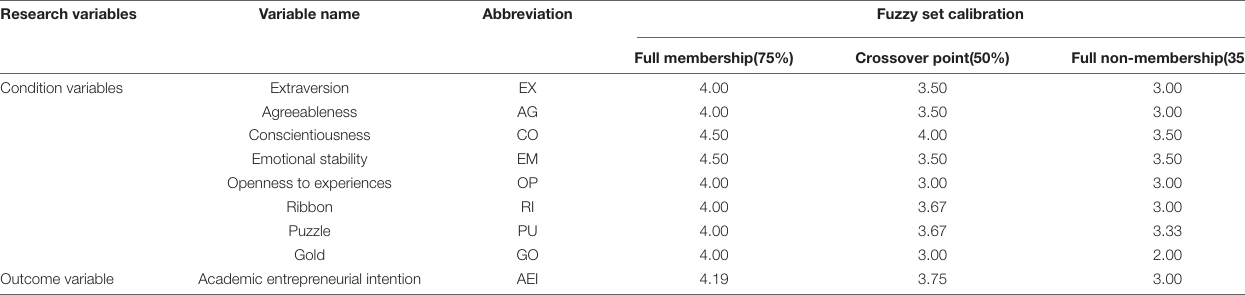
TABLE 8 | Configurations of high and not-high academic entrepreneurial intention for robustness analysis (full non-membership threshold was 35%). Condition